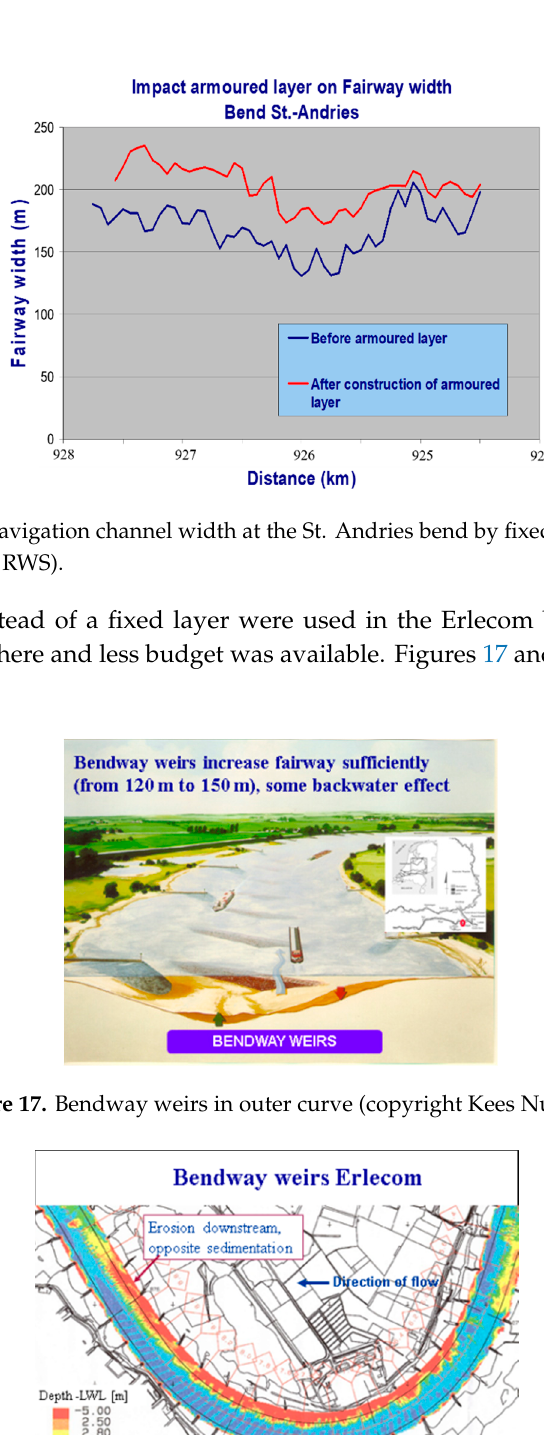
Figure 15. Location of the St. Andries fixed layer. Erosion in dark blue (copyright RWS).